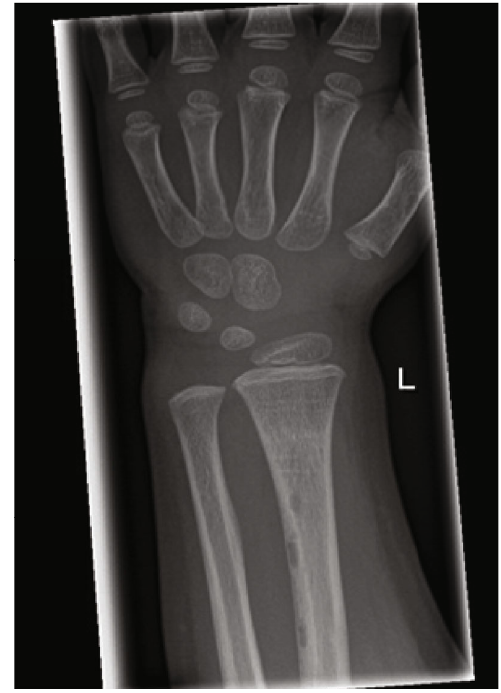
Figure 2: Anteroposterior radiograph showing complete consolidation and three well-circumscribed lucent lesions in the cortex, proximal to the previous fracture